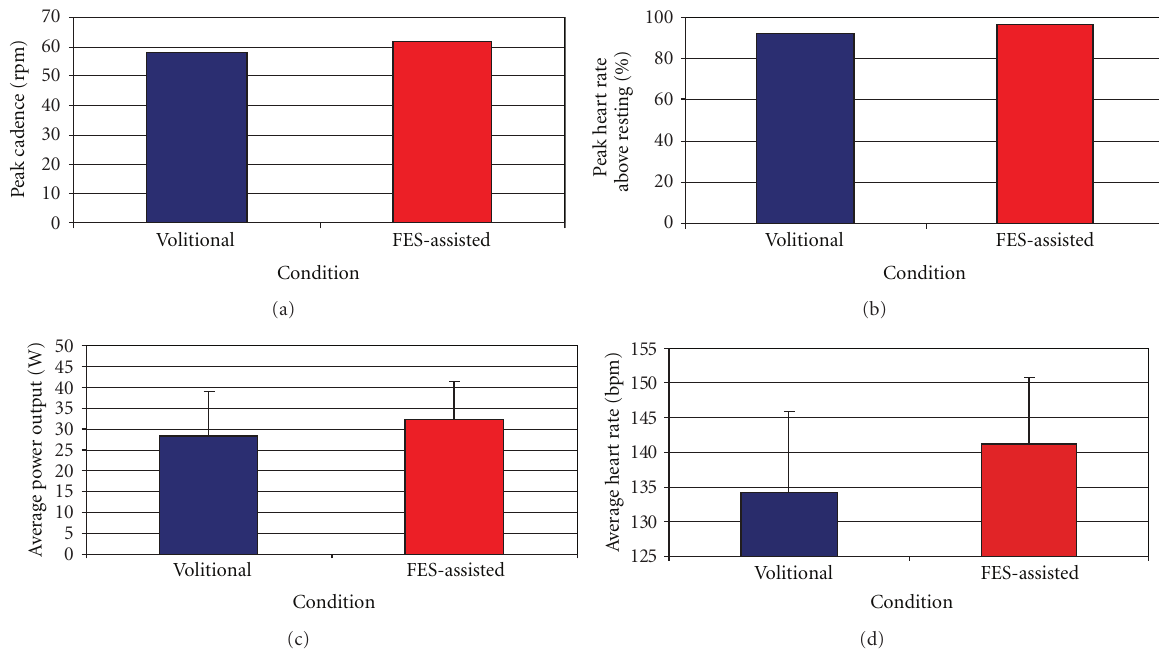
Figure 3: Cycling performance during incremental cycling tests with and without FES assistance in a child who is well adept at cycling (participant 1). The graphs illustrate peak cadence (a), peak heart rate as a percentage of resting heart rate (b), average power output (c), and average heart rate (d) during the tests. For average power output (c) and average heart rate (d) standard deviation values are shown. The blue bars represent volitional cycling and the red bars represent FES-Assisted cycling trials.